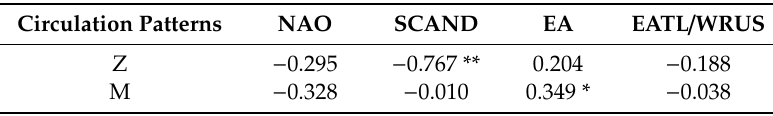
Table 1. Pearson’s correlation coe ffi cients between indices of the macroscale circulation patterns